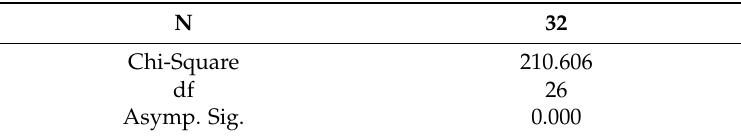
Table 7. Test s of Friedman test for prioritization of benefits of VIM.